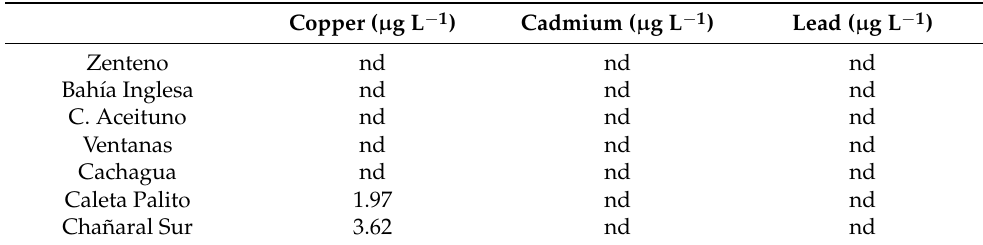
Table 1. Levels of copper, cadmium and lead in seawater of control sites and copper-polluted sites in northern and central